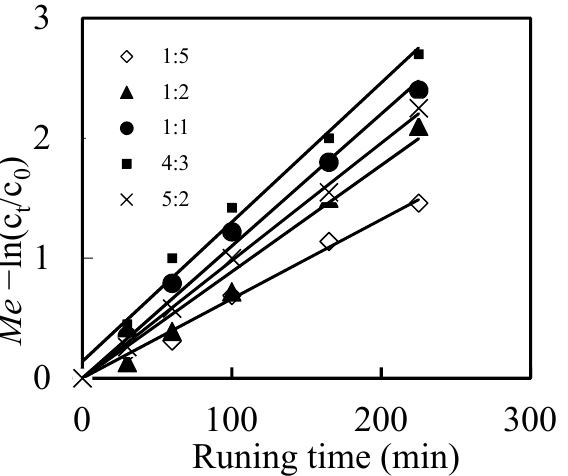
Figure 4. Effects of the volume ratio of diesel to NaOH on the migration efficiency ( Me ) of Mo(VI). Moreover, N-503 played important roles for the migration efficiency of the Mo(VI). Based on Equations (1) and (2), the higher N-503 is, the higher chances of the formation of complexation [([N-503]H) 6 Mo 7 O 24 ] are, which increased the migration efficiency ( Me ) of Mo(VI) (Figure 5). It was noticed that the differences on Me of Mo(VI) was much when the N-503 concentration changed from 0.21 mol/L to 0.25 mol/L. Considering the removal efficiency and solvent cost, 0.21 mol/L was selected as the optimum carrier concentration.